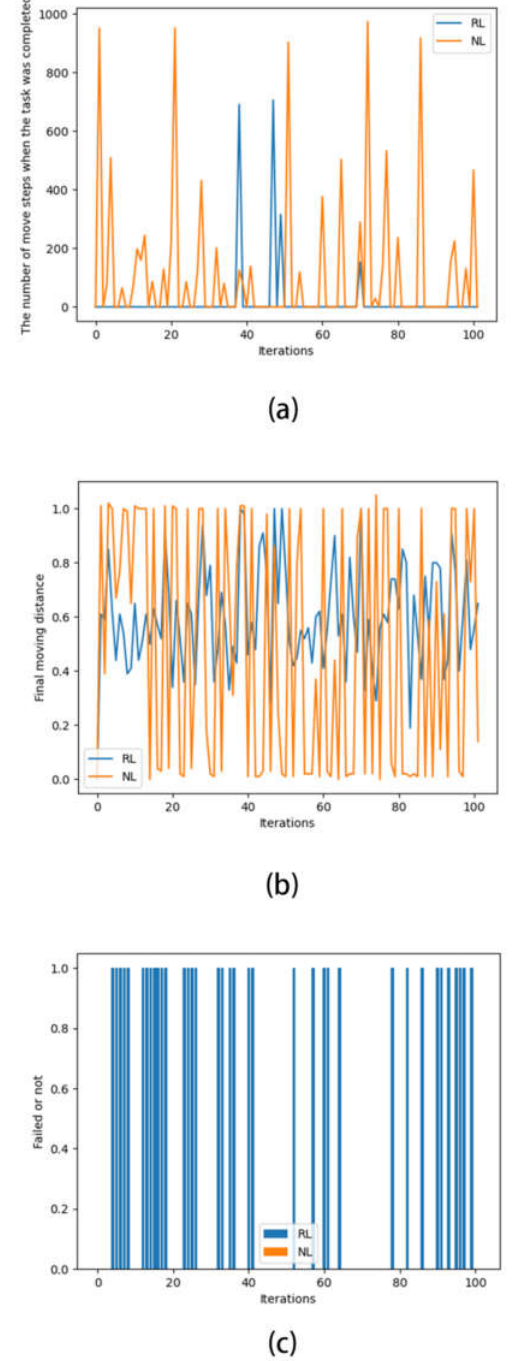
Figure 8. Simulation test results. ( a ) Diagram of the number of moving steps when the quadruped robot movement; ( b ) change chart of final moving distance in comparative test of quadruped robot movement; ( c ) task failure diagram of comparative test of quadruped robot movement.